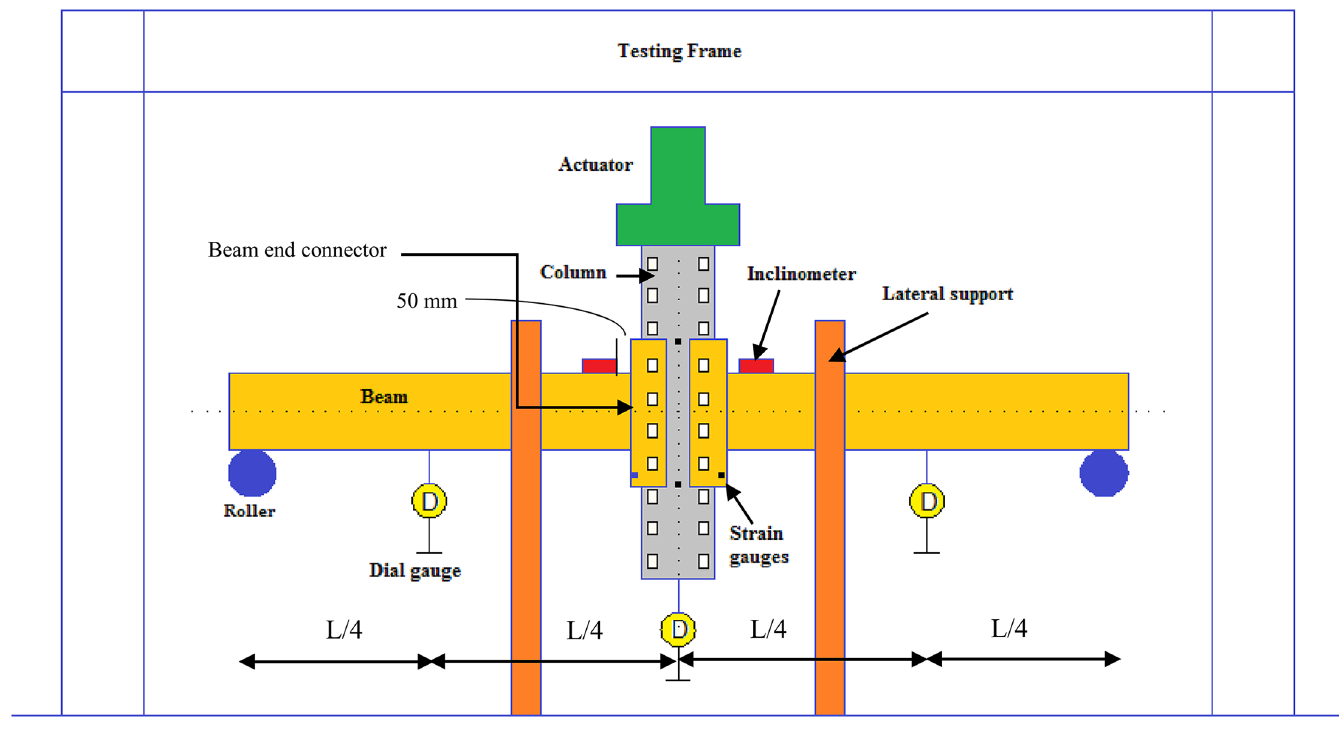
Fig 4. Schematic diagram of test